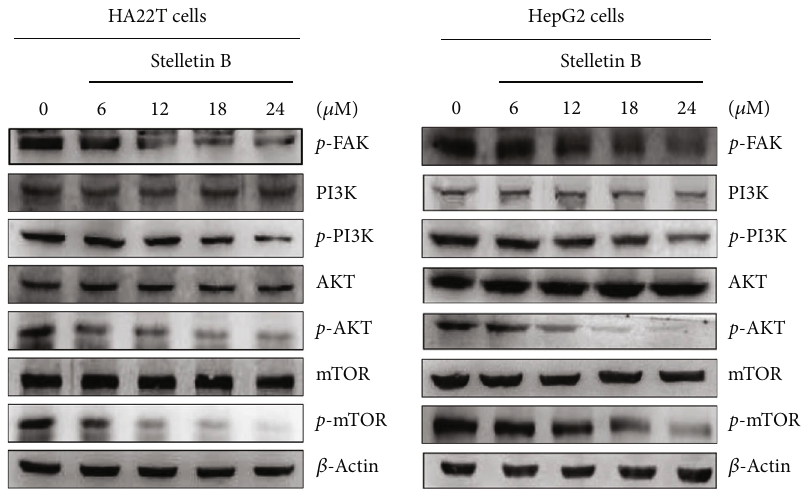
Figure 5: Stellettin B regulated the expression levels in the PI3K/AKT/mTOR signaling pathway. Western blotting analysis was employed to analyze the expressions levels of p -FAK, p -PI3K, p -AKT, and p -mTOR in HA22T and HepG2 cells treated with Stellettin B. Zero refers to cells treated with DMSO vehicle as a control. β -Actin was used as the internal